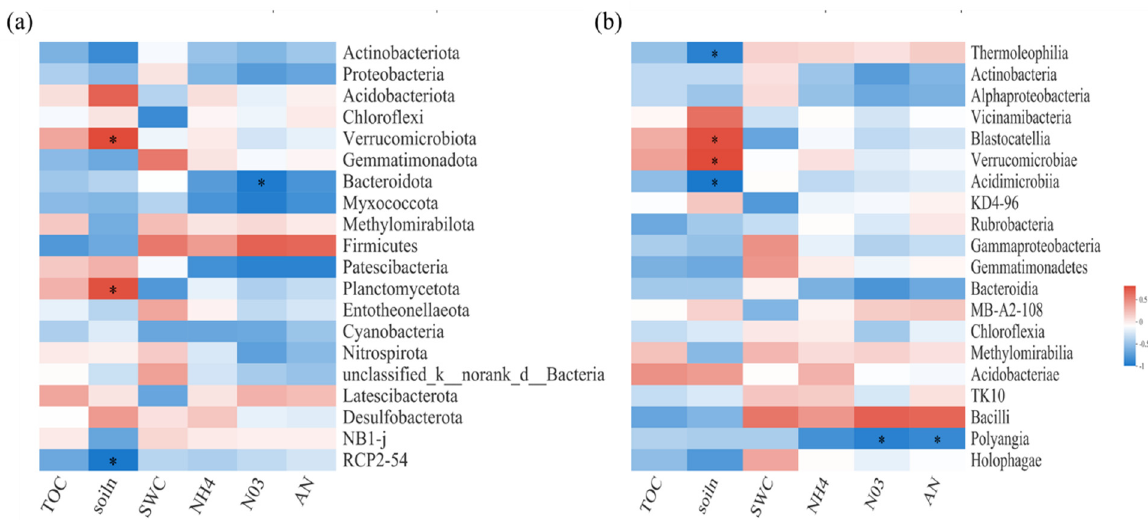
Figure 3. Spearman correlation heatmaps of environment factors, biochemical properties, and bac- terial gene read numbers at the phylum ( a ) and class ( b ) levels. TOC: organic carbon; NH4: ammo- nium nitrogen; NO3: nitrate nitrogen; AN: available nitrogen; soiln: soil total nitrogen. SWC: soil water content. The color intensity in each panel indicates the relative correlation between soil prop- erties and read numbers of each group. Statistically significant correlations are indicated with * p ≤ 0.05.